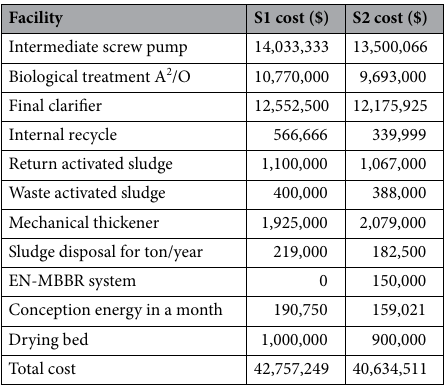
Table 11. Comparison of costs between Scenarios 1 and